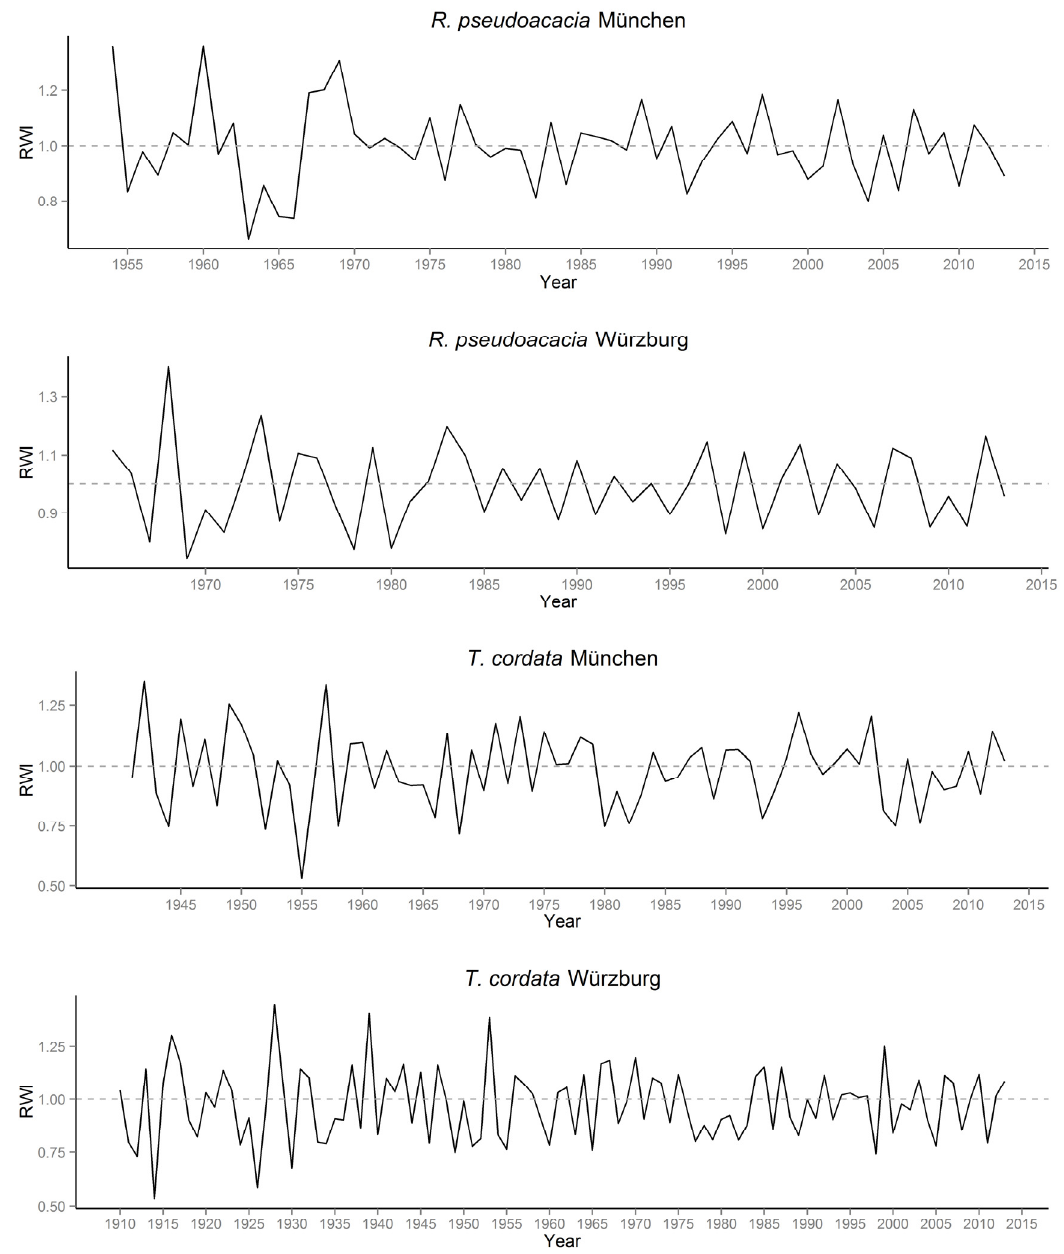
Figure 2. Ring width index of Robinia pseudoacacia and Tilia cordata in München and Würzburg after double detrending (negative exponential function and 2/3 cubic smoothing spline).